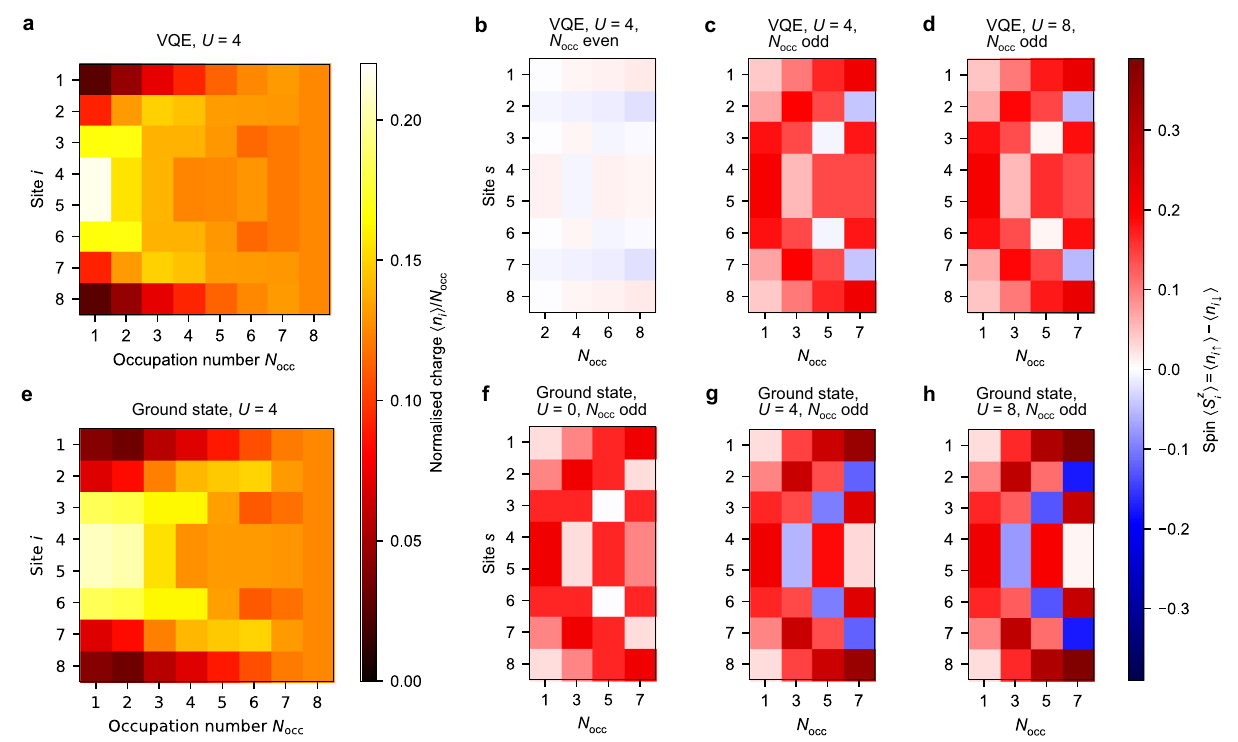
Fig.5|Chargeandspindensitiesfora1×8lattice. Inallpanelsthe X axisgivesthe occupation number N occ while the Y axis gives the site index. The top row shows experimental VQE results, while the bottom one displays exact ground state